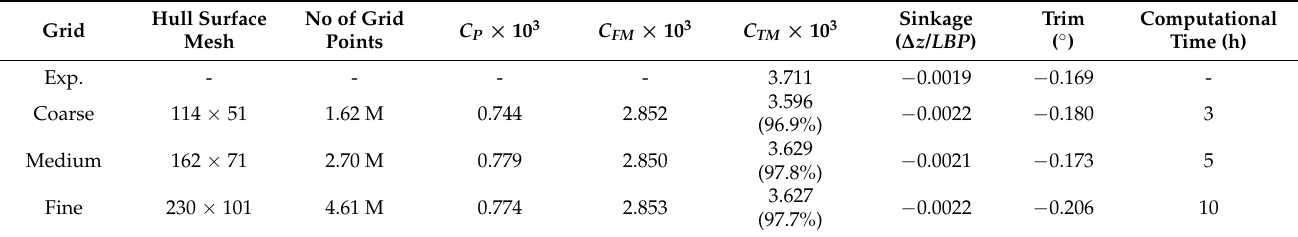
Table 3. Results of grid convergence test for the original KCS hull ( Fn = 0.26